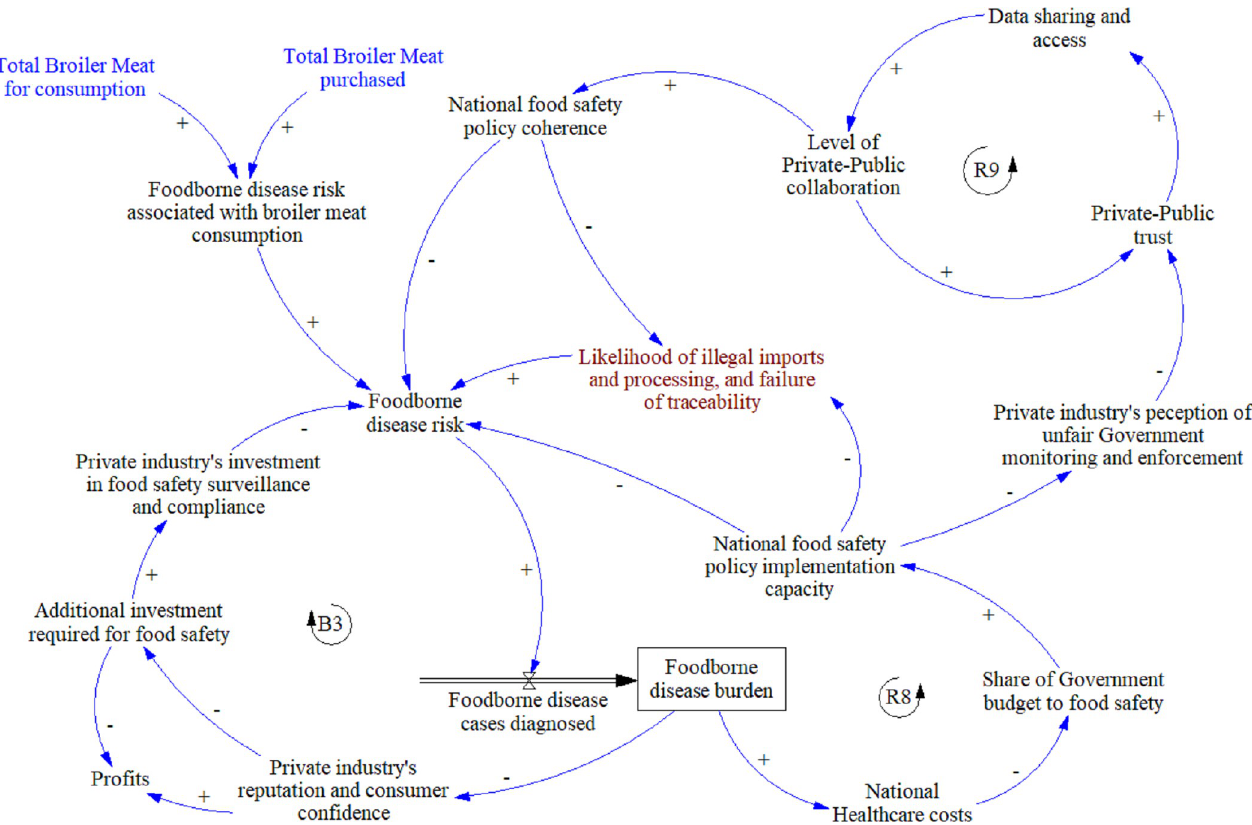
Fig 6. Food safety and foodborne disease surveillance module. Key: Blue text: elements linking to other modules, Brown text: elements added after meeting with stakeholders.